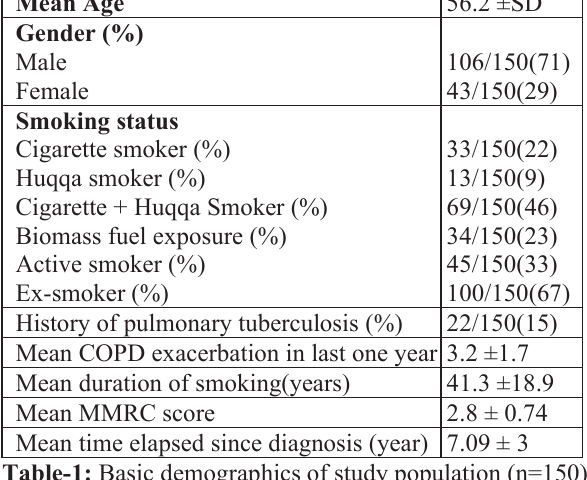
Table-1: Basic demographics of study population (n=150) Bronchiectasis